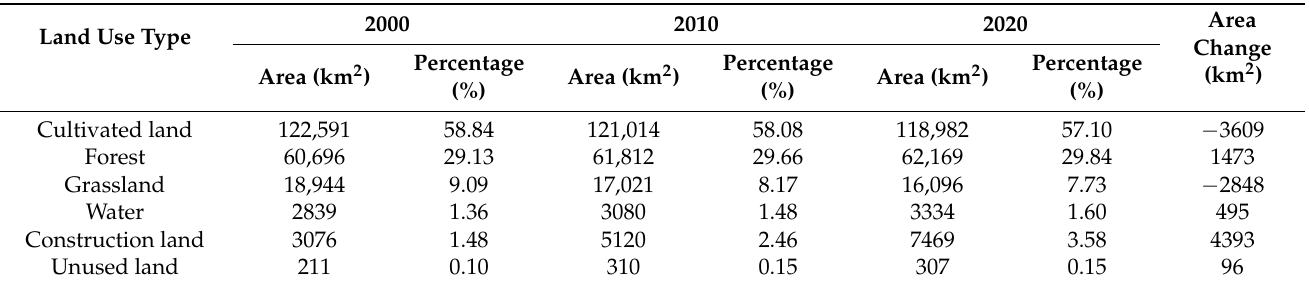
Table 5. Area and percentage of the study area’s various land-use classifications through 2000 to